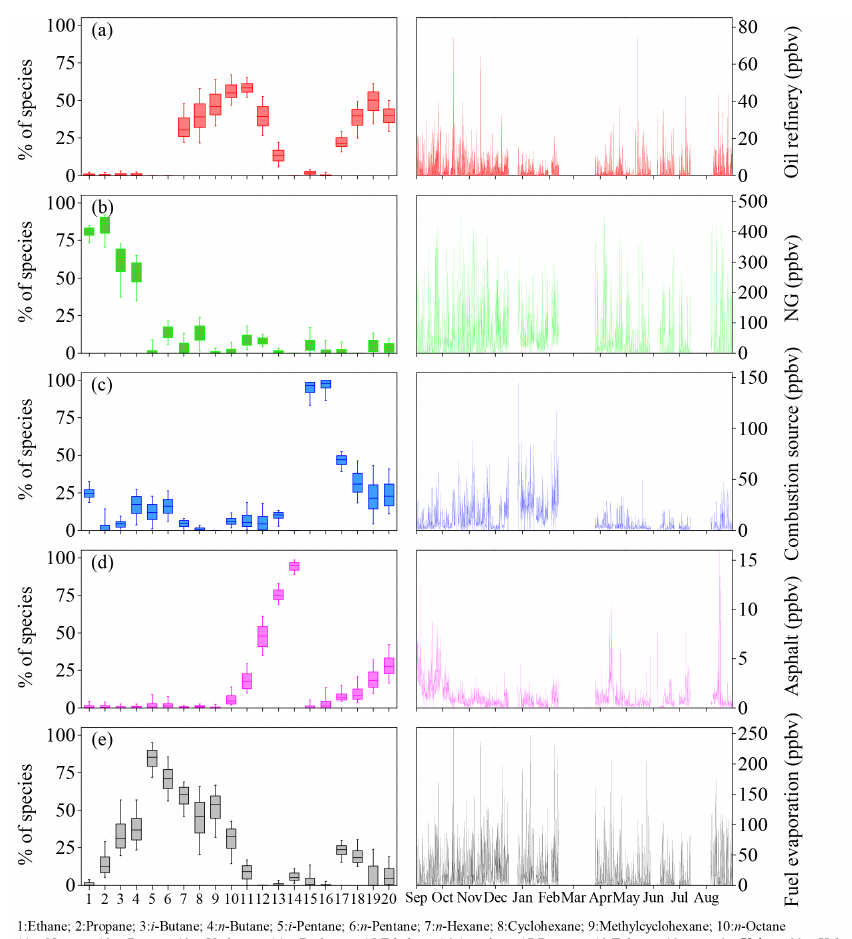
Figure 10. Source profiles of five factors resolved with PMF modeling including oil refineries (a) , NG (b) , combustion source (c) , asphalt (d) , and fuel evaporation (e) and their corresponding hourly source contributions. Box and whisker plots are constructed according to the 5th–95th percentiles of the F -peak bootstrap runs ( n =